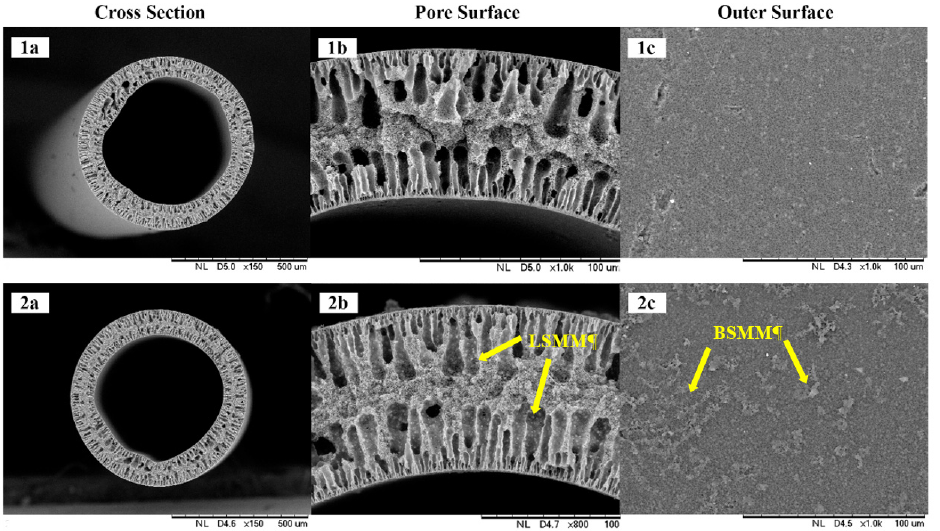
Figure 5. FESEM pictures of the prepared membranes: ( 1 ) PVDF/PEG, ( 2 ) PVDF/PEG/3LSMM- BSMM 1 in which ( a ) exhibits cross section view, ( b ) exhibits pore surface, ( c ) exhibits outer surface. With respect to membrane physical characteristics, it is found that LSMM played a role in increasing membrane thickness (Table 3). Membrane thickness impacts both mass and heat transfer in a different correlation when implemented in the MD process. Membrane thickness is inversely proportional to the permeate flux, where an increase in thickness has a negative effect, and lower flux occurs due to its role as a mass transfer resistance [3,9,25], and vice versa. This study obtained the thickness of the membrane was increased from 165 to 183 µ m in which is still in the range of common commercial membrane for MD that ranged from 40 to 250 µ m [7]. Aside from the membrane effect on flux permeation, the thickness also reflects the mechanical strength of the membrane [22]. The higher polymeric